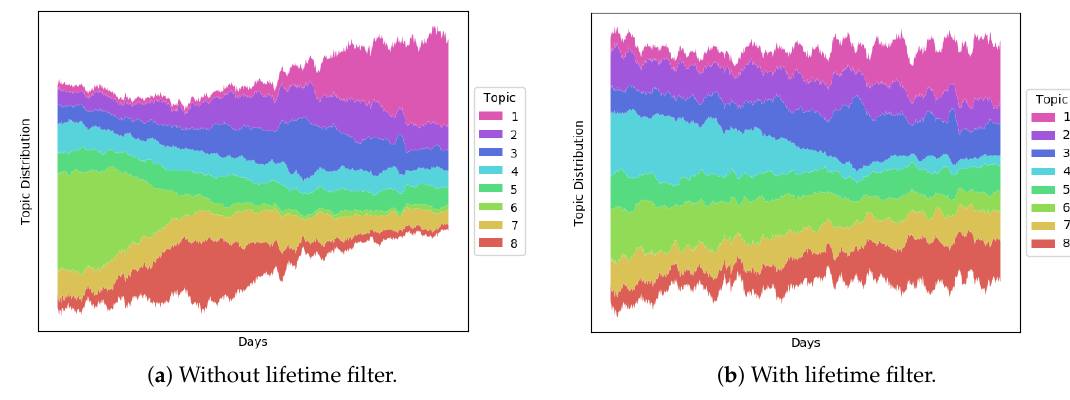
Figure 1. Lifetime filter can moderate temporal biases caused by temporary